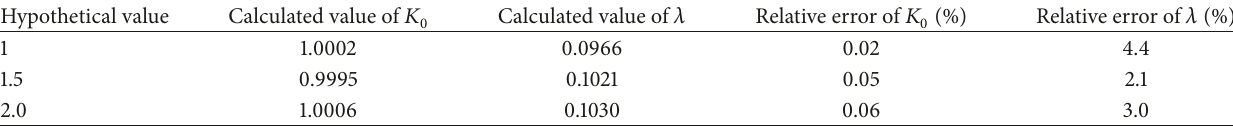
Table 3: The value of 𝐾 0 , 𝜆 and the average relative error.